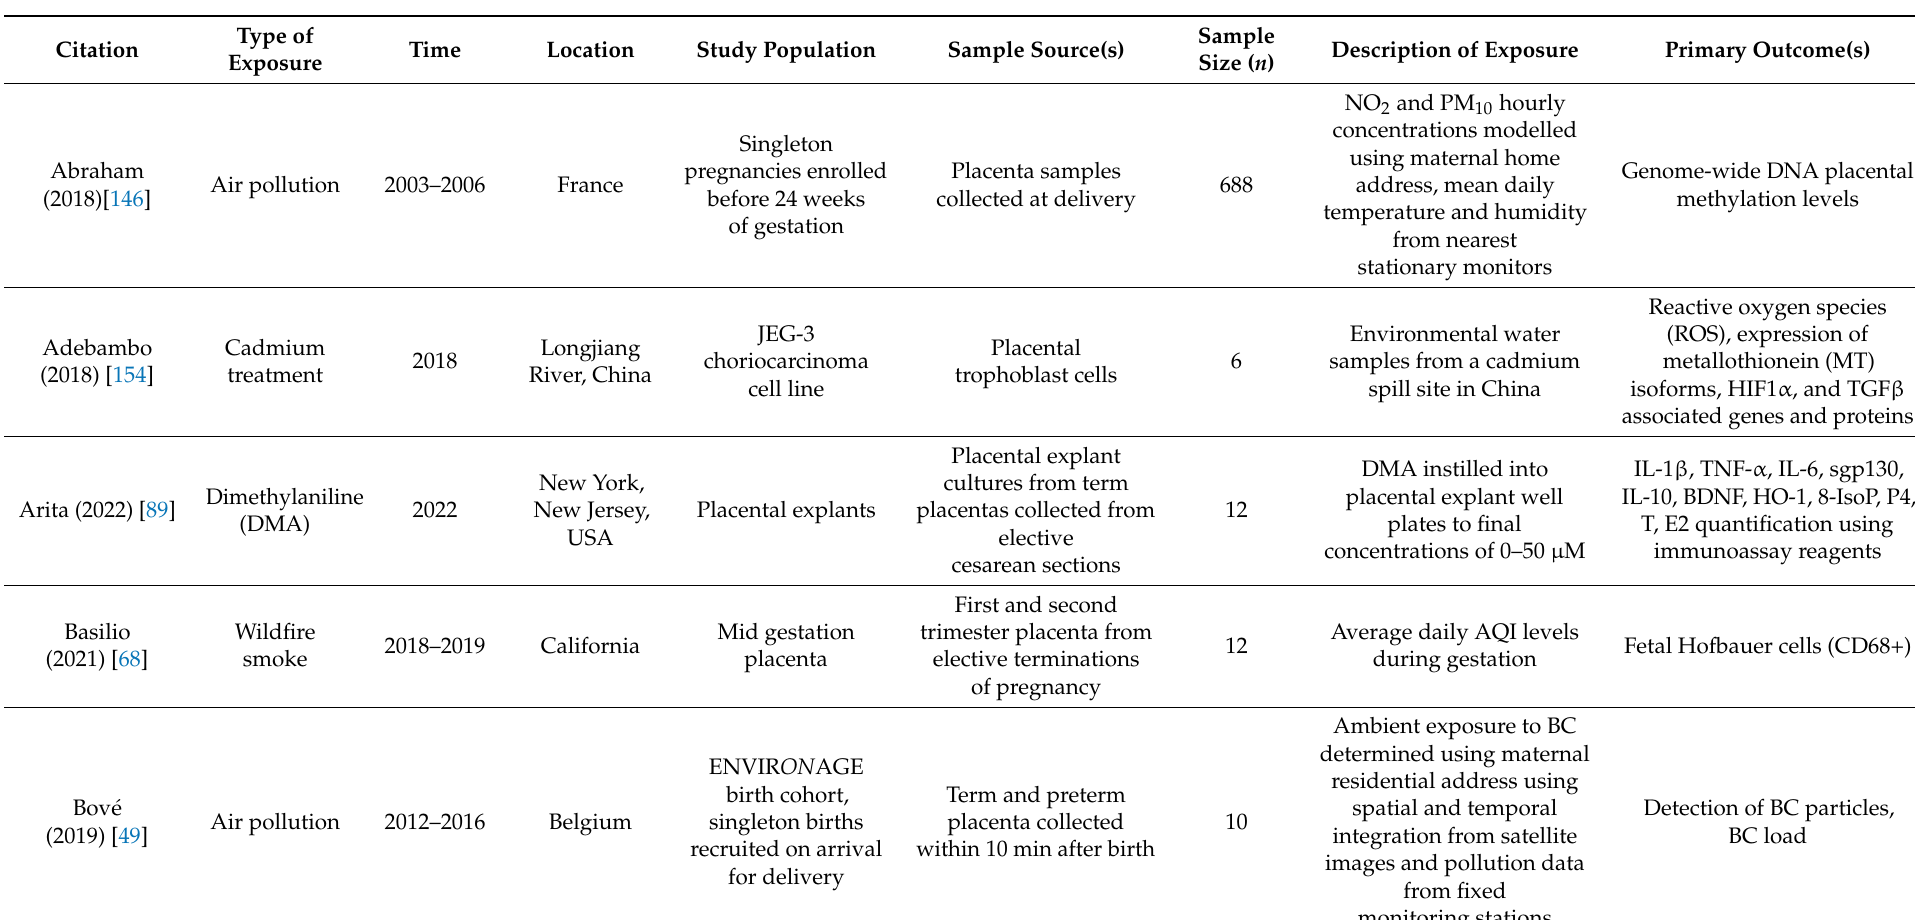
Table 3. Summary of human placental studies included in our review. For each paper, we provide the citation, time frame, location, study design, study population, and sample size. We also provide a description of the exposure. Finally, we indicated the primary and secondary outcomes observed, if applicable. Citations are listed in alphabetical